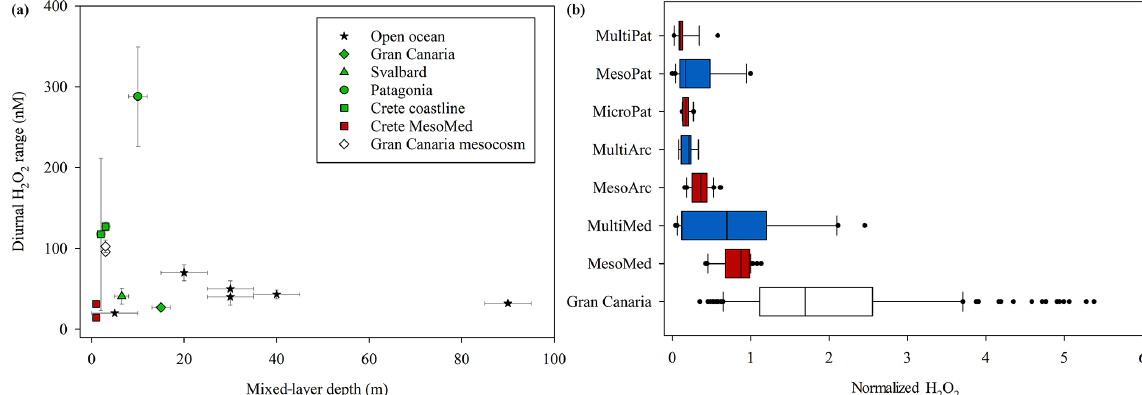
Figure 11. (a) Observed diurnal ranges in H 2 O 2 concentrations. Black stars show literature surface marine values and green shapes in situ experiments corresponding to experiment field site locations. (b) H 2 O 2 across all experiments as a fraction of ambient H 2 O 2 . For the Meso– Multi field sites (Mediterranean, Arctic and Patagonia) red bars are outdoor mesocosms and blue shapes indoor incubations. The median; 10th, 25th, 75th, and 90th percentiles; and all outliers are